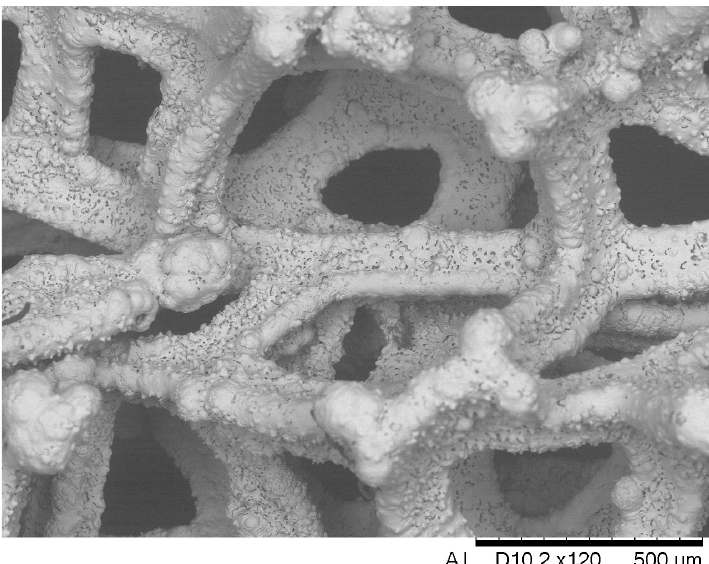
Figure 2. SEM image of 3D copper foam.